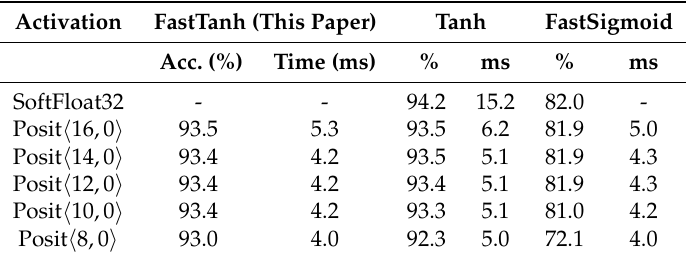
Table 7. Comparison using Posits for the GTRSB dataset (see Table 6).